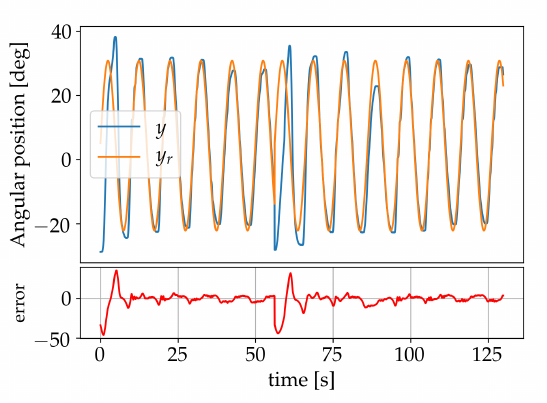
Figure 13. Learning session using a sine wave as reference signal.